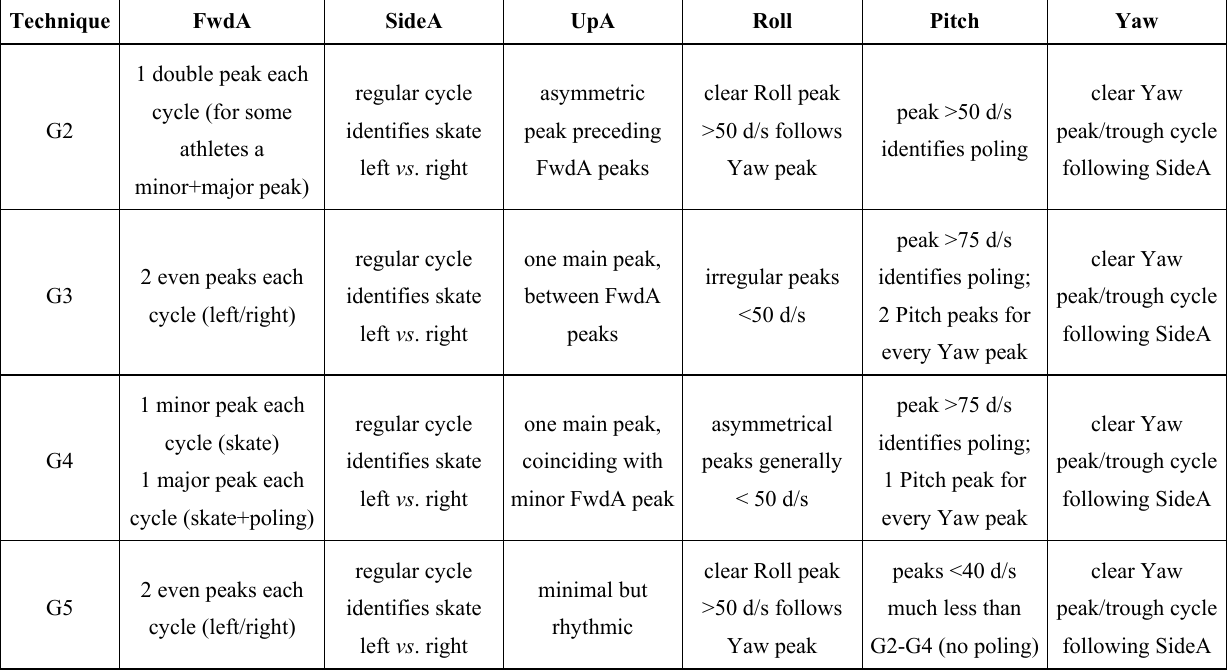
Table 2. Skating technique features common to all